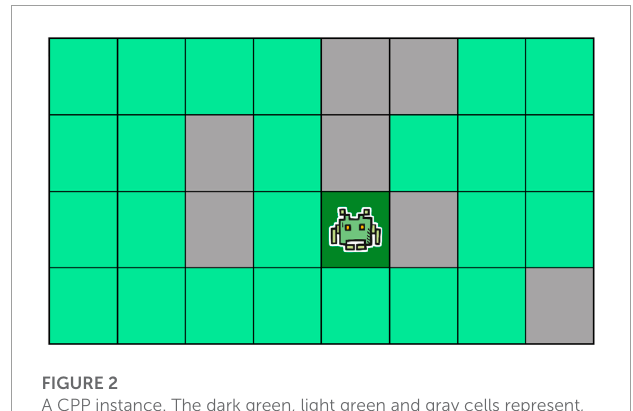
FIGURE 2 A CPP instance. The dark green, light green and gray cells represent, respectively, the initial cell, the cells that remain to be covered and the inaccessible